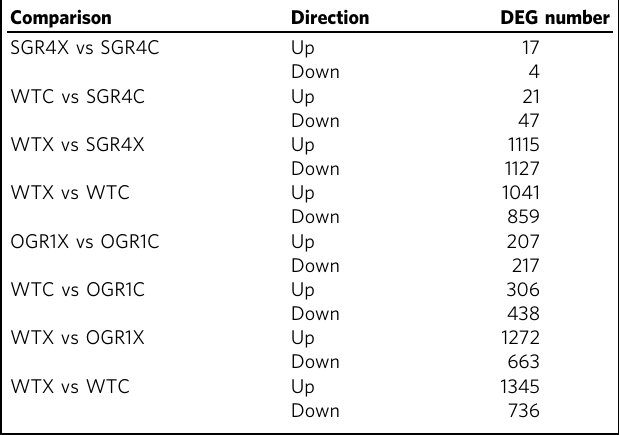
Table 1 Number of DEG per